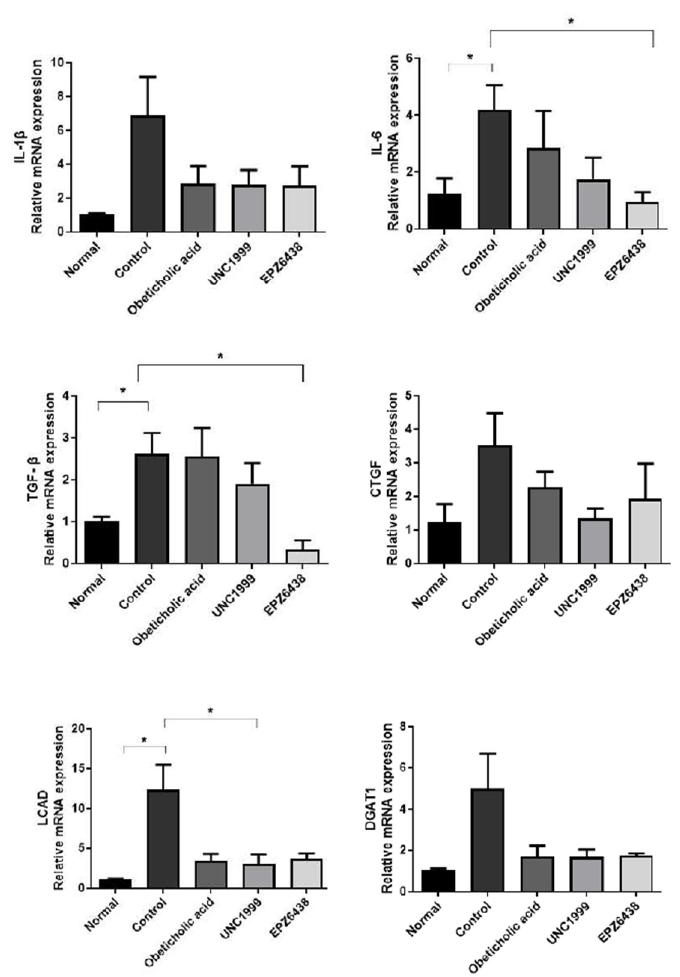
Figure 5. Treatment with EZH2 inhibitors inhibits liver inflammation and fibrosis-related genes in STAM NASH mice. Gene expression of inflammatory and fibrosis markers from Real-Time PCR. Expression of marker genes in healthy (Normal), STAM-Vehicle (Control), STAM-Obeticholic acid (Obeticholic acid), STAM-UNC1999 (UNC1999) and STAM-EZH2 (EPZ6438) groups in the NASH mice. The final concentration of Obeticholic acid, UNC1999 and EPZ6438 is 10 mg/kg. Statistically significant differences versus the STAM-Vehicle group and EZH2 inhibitors treatment group are marked as * p < 0.05, respectively.